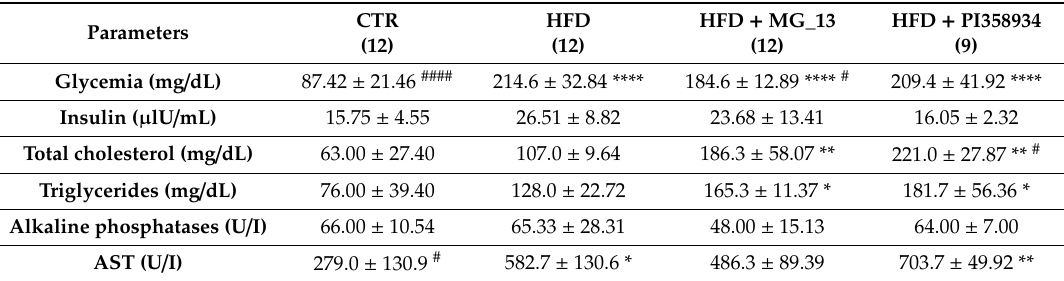
Table 2. Biochemical analysis of serum parameters of CTR and HFD